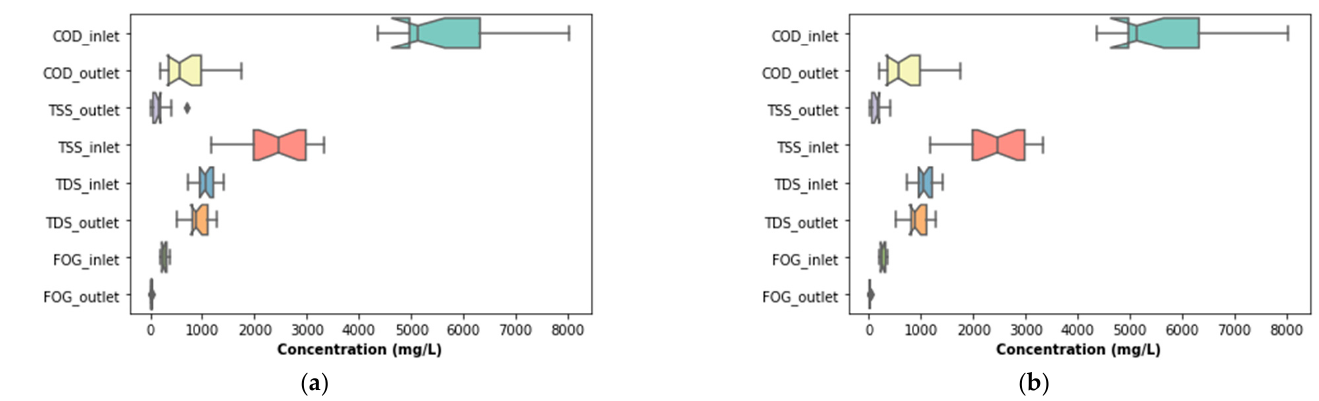
Figure 13. Boxplots of the DEGBR highlighted features before and after outliers’ replacement: ( a ) Boxplots before outliers’ replacement; ( b ) boxplots after outliers’ replacement